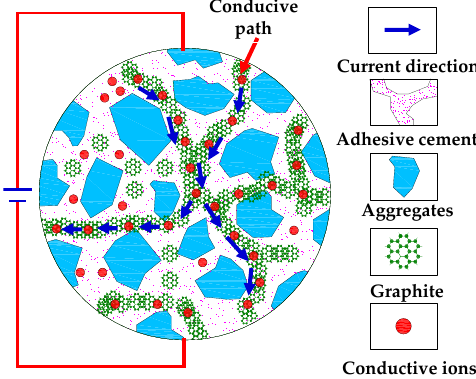
Figure 6. Conductive paths formed by graphite.